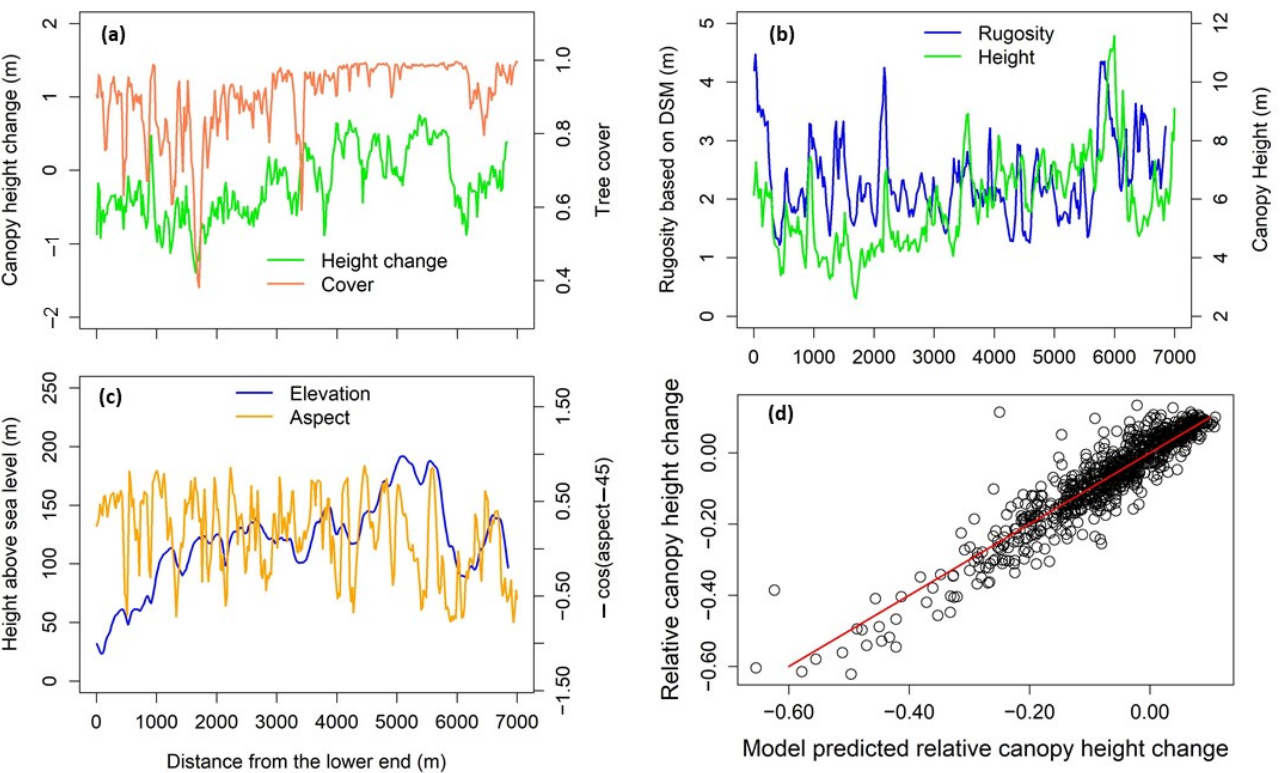
Figure 5. The canopy height change calculated by subtracting the LiDAR-derived canopy height model on 8 March 2017 from the LiDAR-derived canopy height model on 28 May 2018 along the transect within the Guánica forest ( a ): tree cover ( a ), rugosity based on digital surface model (DSM) ( b ), canopy height ( b ), elevation ( c ), and cosine function of aspect ( c ) were derived from the G-LiHT LiDAR data, indicating the status before the hurricanes. The predicted versus monitored relative canopy height change is shown in ( d ).